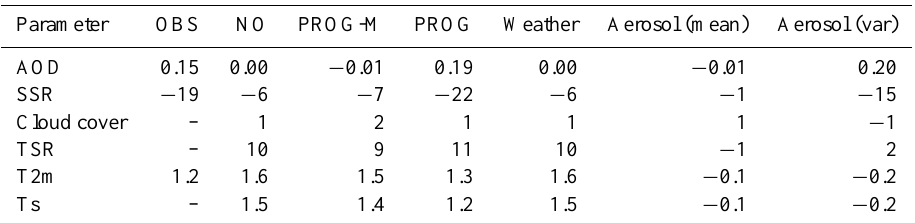
Table 6. Composite study for Murcia: differences between dusty days and the set of all the days in observations (OBS), NO, PROG-M and PROG for AOD, downward SSR (Wm − 2 ), cloud cover (%), downward TSR (Wm − 2 ), 2m temperature ( ◦ C) and soil temperature (Ts, ◦ C). The contribution of the different effects, namely weather, aerosol (mean) and aerosol (variability), have been added.